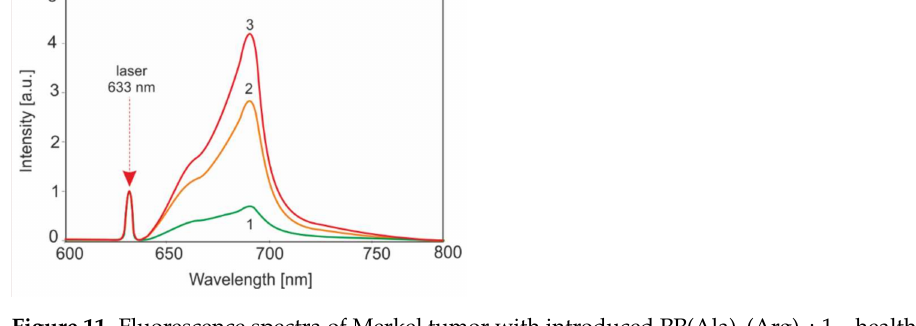
Figure 11. Fluorescence spectra of Merkel tumor with introduced PP(Ala) 2 (Arg) 2 : 1—healthy tissue, 2—tumor on the periphery, 3—tumor in the center of lesions.